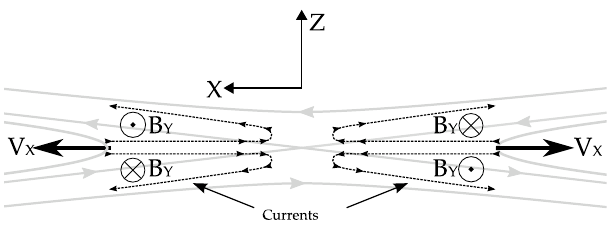
Fig. 1. The quadupolar signature in B Y created from the Hall cur- rent system around a X-line. Adopted from Sonnerup